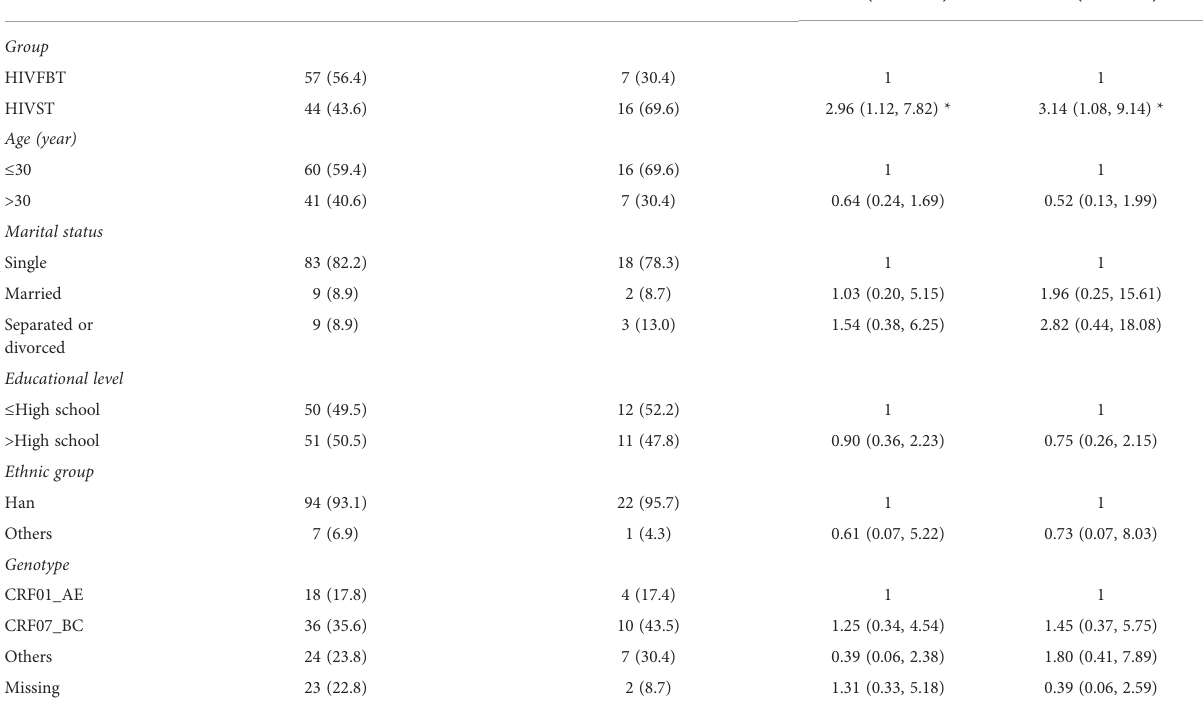
TABLE 4 Univariate and multivariate logistic analyses of factors associated with recent HIV infection by RITA 4 (N = 124).